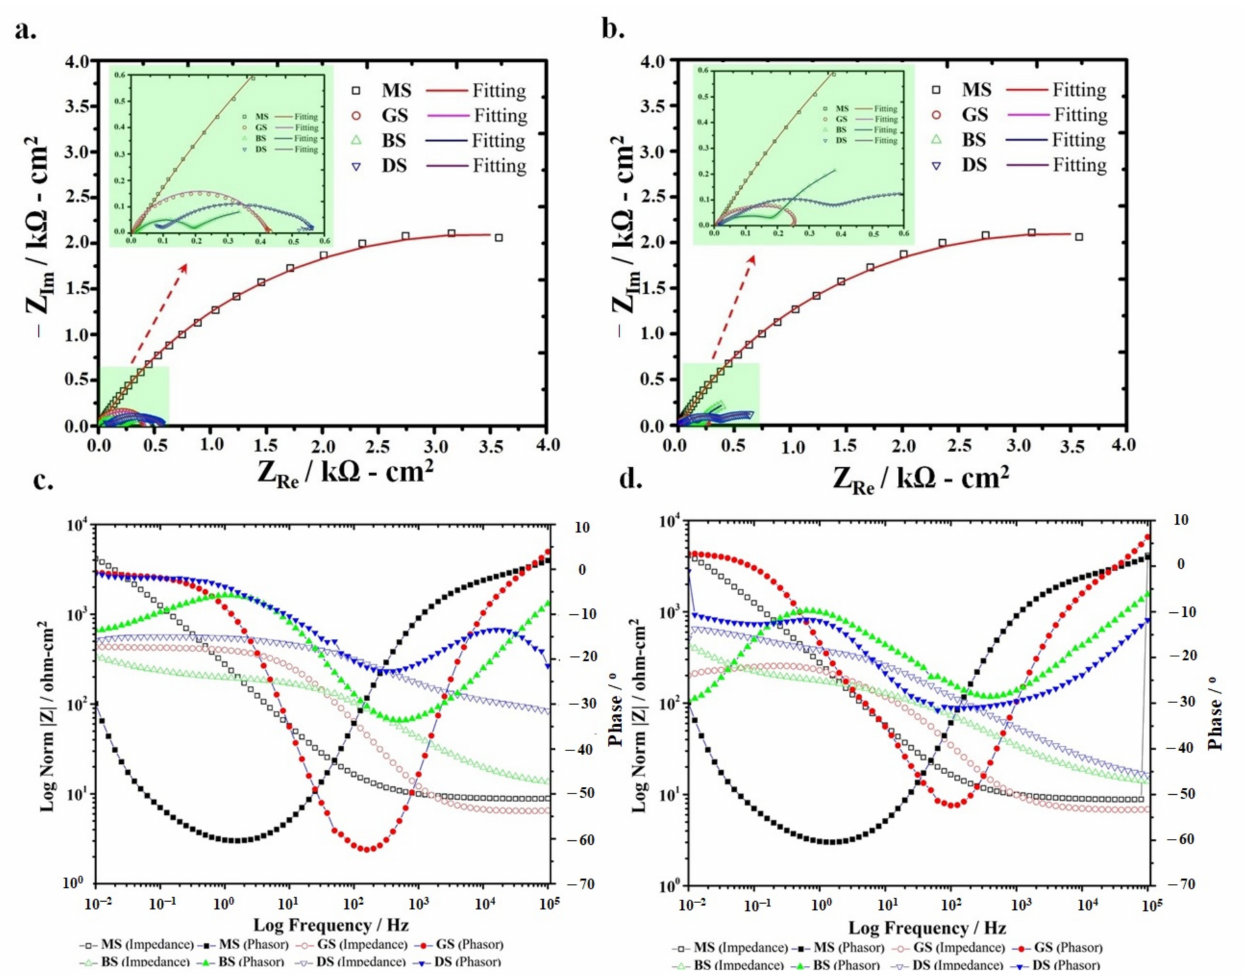
Figure 3. Mild steel (MS)and Zn-coated samples in 3.5% NaCl Nyquist plots of after ( a ) one hour and ( b ) 24 h of exposure and Bode plots after ( c ) one hour and ( d ) 24 h of